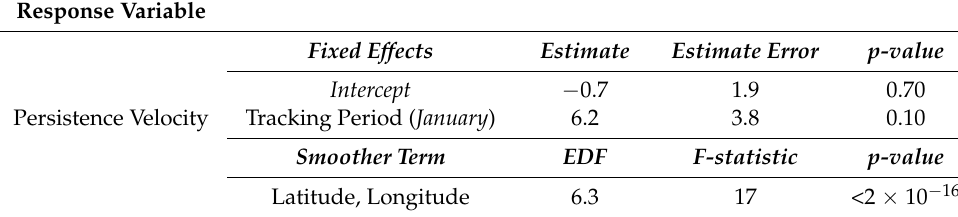
Table 2. Results of the final fitted generalized additive mixed model (GAMM) for turtle swimming persistence velocity (km day − 1 , Gaussian error, identity link function). Final model structures were selected using AIC comparison. The final model had a linear term for tracking period (July as the reference level to January) and a non-linear smoothing and interaction term for location (latitude, longitude). The model also included individual turtle tracks as random effects and accounted for temporal autocorrelation using a correlation autoregressive moving average (ARMA) structure with p = 4 and q =